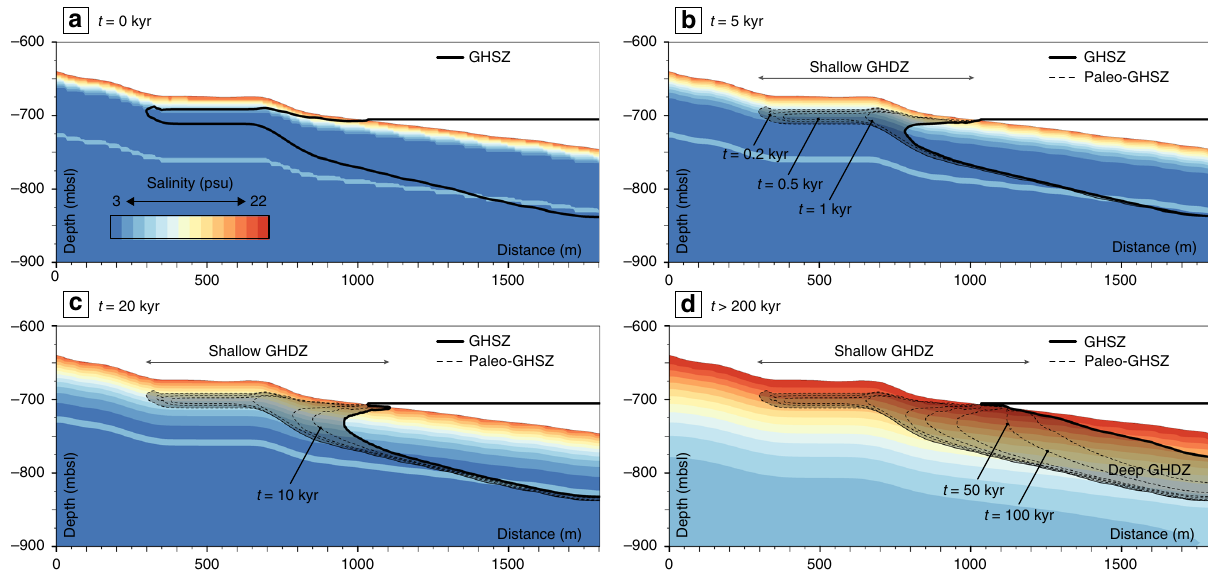
Fig. 3 Simulation of the evolution of the GHSZ over time. The results of the simulation using the two-dimensional numerical model developed by Sultan et al. 38 are presented through 4 steps of the calculation: a t = 0 kyr, b t = 5 kyrs, c t = 20 kyrs, and d t > 200 kyrs. The landward termination of the GHSZ evolve over time. Hydrate deposit, the gray area, named “ Gas Hydrate Destabilization Zone ” (GHDZ) is currently undergoing dissociation caused by salt diffusion through sediments. This simulation is performed using the shallow part of the seismic pro fi le presented in Fig. 2. All the steps of the calculation ( t = 0, 0.2, 0.5, 1, 5, 10, 20, 50, 100 and > 200 kyrs) are presented in the Supplementary Fig. 4